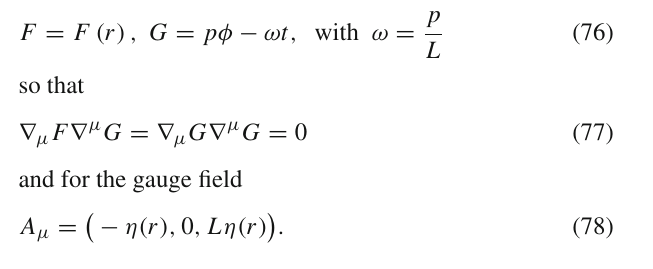
(cid:9)(cid:4) (cid:5)(cid:4) (cid:5) δ ∇ μ F ∇ μ F ( ∇ ν G + A ν ) δ A ν